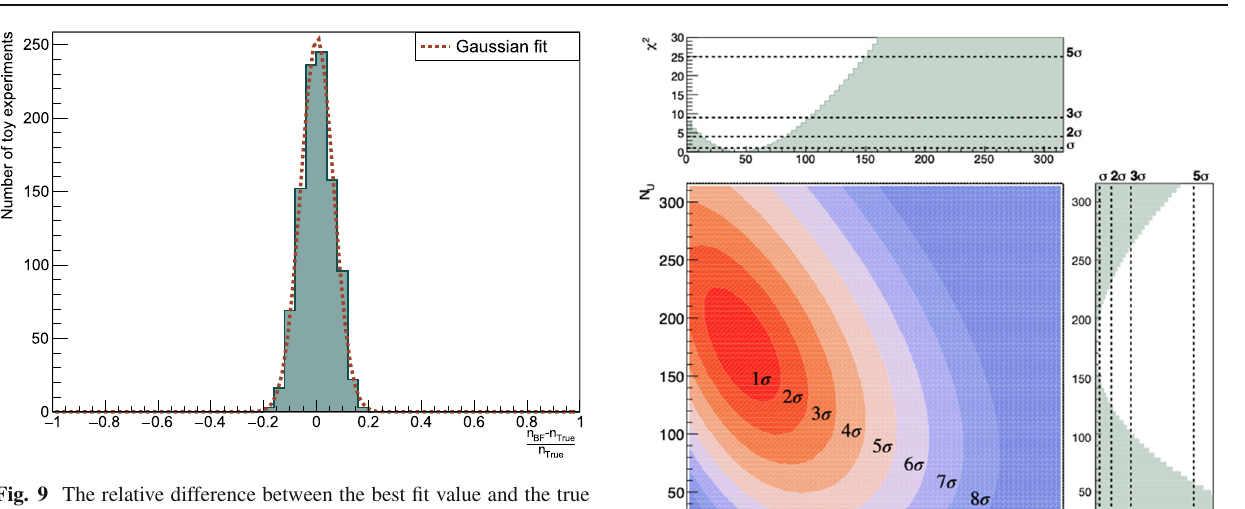
Fig. 9 The relative difference between the best fit value and the true value of the number of geoneutrinos, obtained with 1000 toy experi- ments Table9 Theresultsofthesensitivitystudiesperformedwithlikelihood fit with free U/Th ratio, for U and Th values, and with fixed U/Th ratio forgeoneutrinos.Thefirstcolumnpresentsbestfitvaluesinrawnumber of events per year, the second column is the result of conversion of the results into NIU that can be compared to other experiments, and finally third column is the input model that was used in the simulation for an easy reference